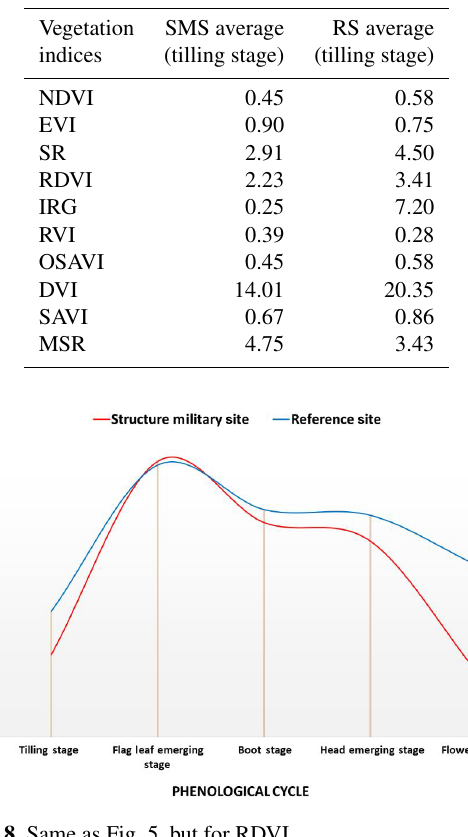
Figure 8. Same as Fig. 5, but for